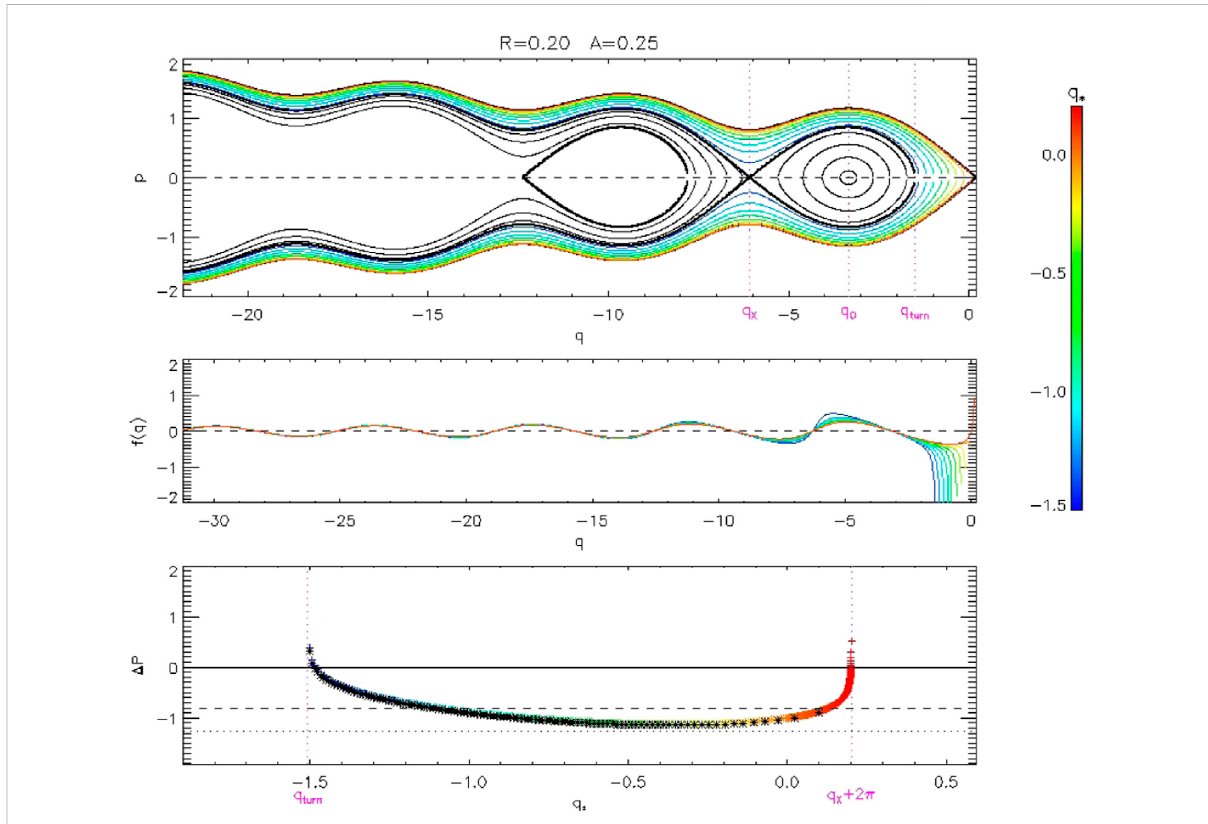
FIGURE 4 Top: Contours of K ( p , q ) for parameters R = 0.2 and A = 0.25, color-coded by q * (the value of q at p = 0). Middle: The function appearing in the integralofEq.13.Bottom:Thecoloredsymbolsshow Δ P vs. q * fromnumericalevaluationofEq.13,whichisnegativeformostbutnotallvaluesof q * . Thehorizontaldashedlineshowstheaveragedvalue,andthehorizontaldottedlineshowsthevalue −( 8/ π ) show the values from Figure